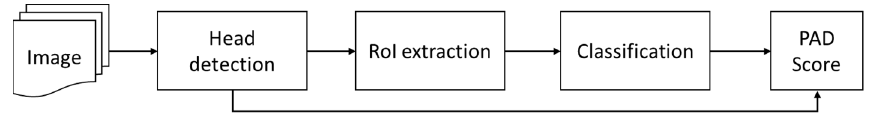
Figure 7. Block diagram of the presentation attack detection method.